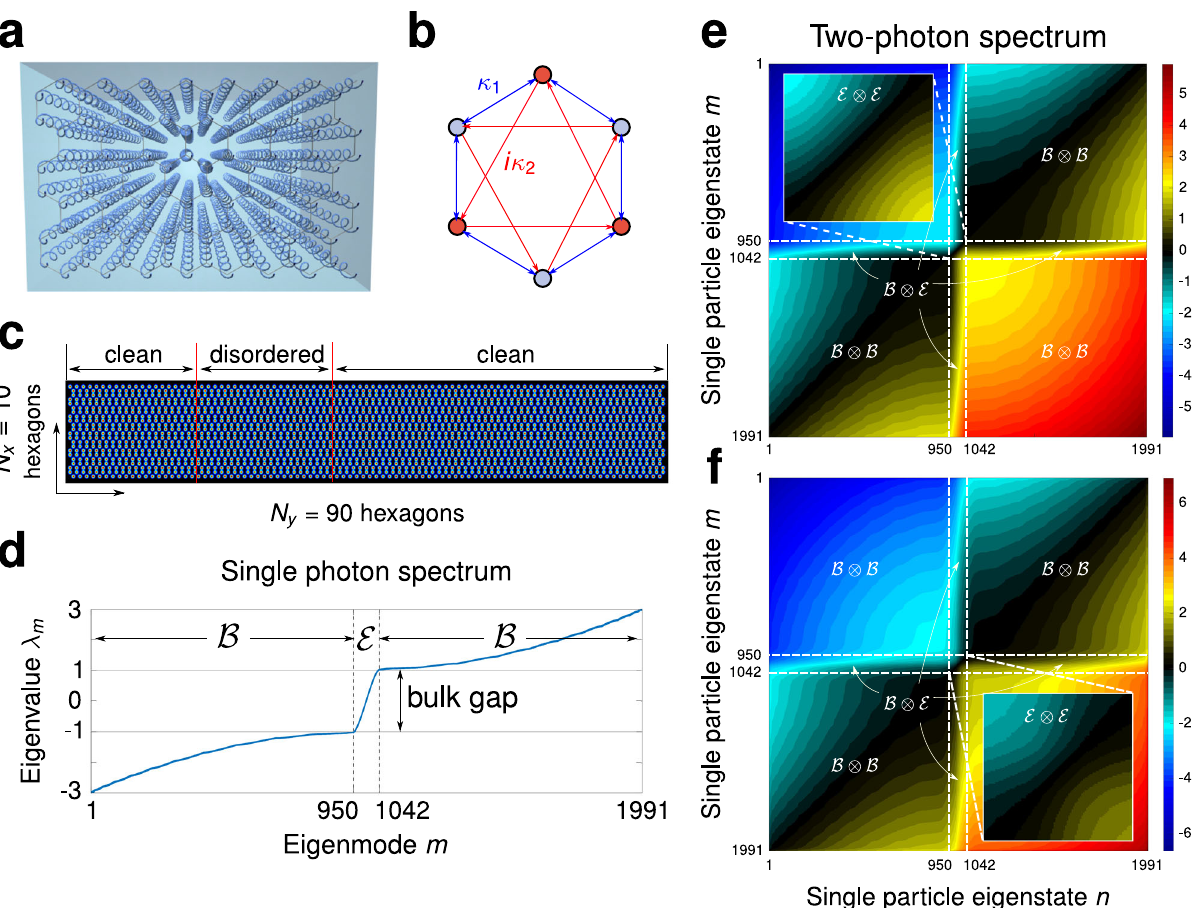
Fig. 1 The Haldane photonic lattice. a Photonic implementation of the Haldane system using a honeycomb lattice of helical waveguides. b Elementary hexagonal cell of the Haldane system, with real-valued nearest-neighbor coupling (blue arrows) κ 1 = 1 and imaginary next-nearest-neighbor coupling (red arrows); κ 2 = i κ 1 /5 along the arrow and − i κ 1 /5 in the opposite direction. c Pictorial view of the fi nite lattice used in our numerical analysis. d Single-photon spectrum formed by eigenvalues λ n . In e and f we show the two-photon eigenspectra without and with disorder, respectively. Colors encode the two- photon eigenvalue λ ð 2 Þ n ; m ¼ λ n þ λ m . For better appreciation we have separated the spectrum into the subspaces edge – edge E (cid:2) E